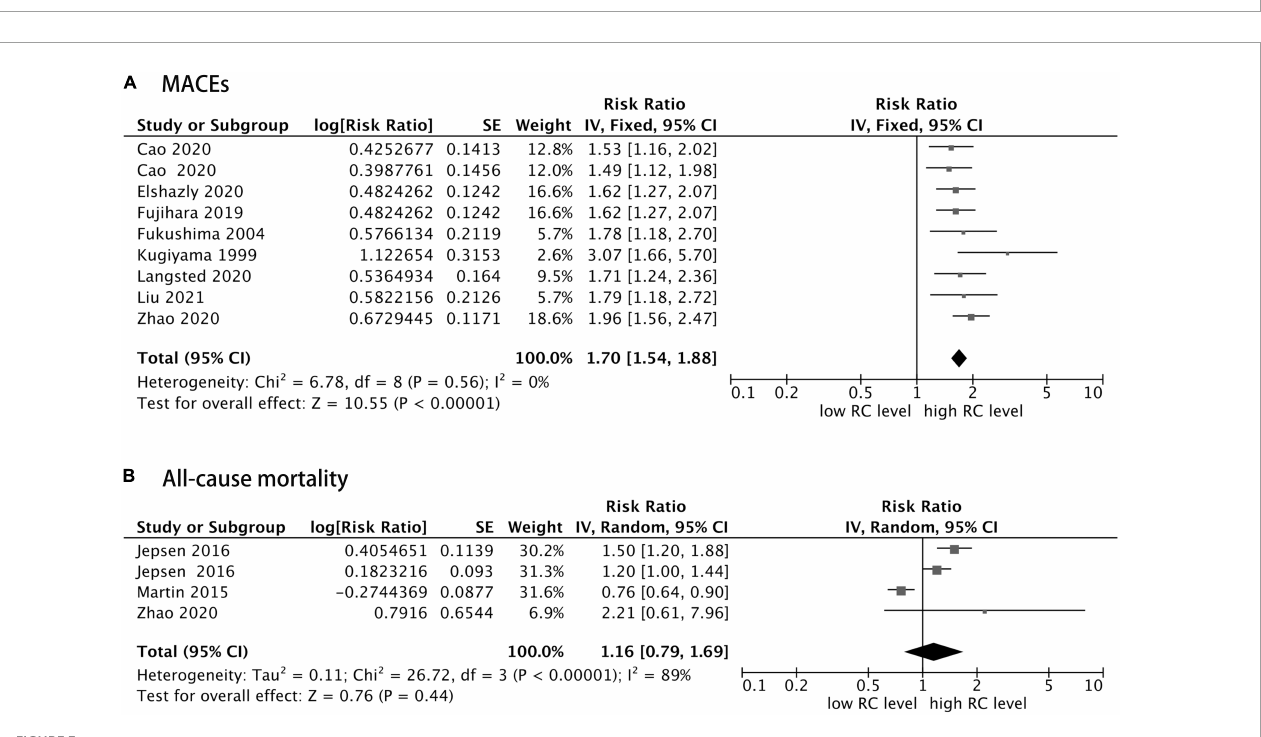
FIGURE3 Forest plots showing the pooled RR with 95% CI of major adverse cardiovascular events (MACEs) (A) and all-cause mortality (B) for the highest versus lowest remnant cholesterol